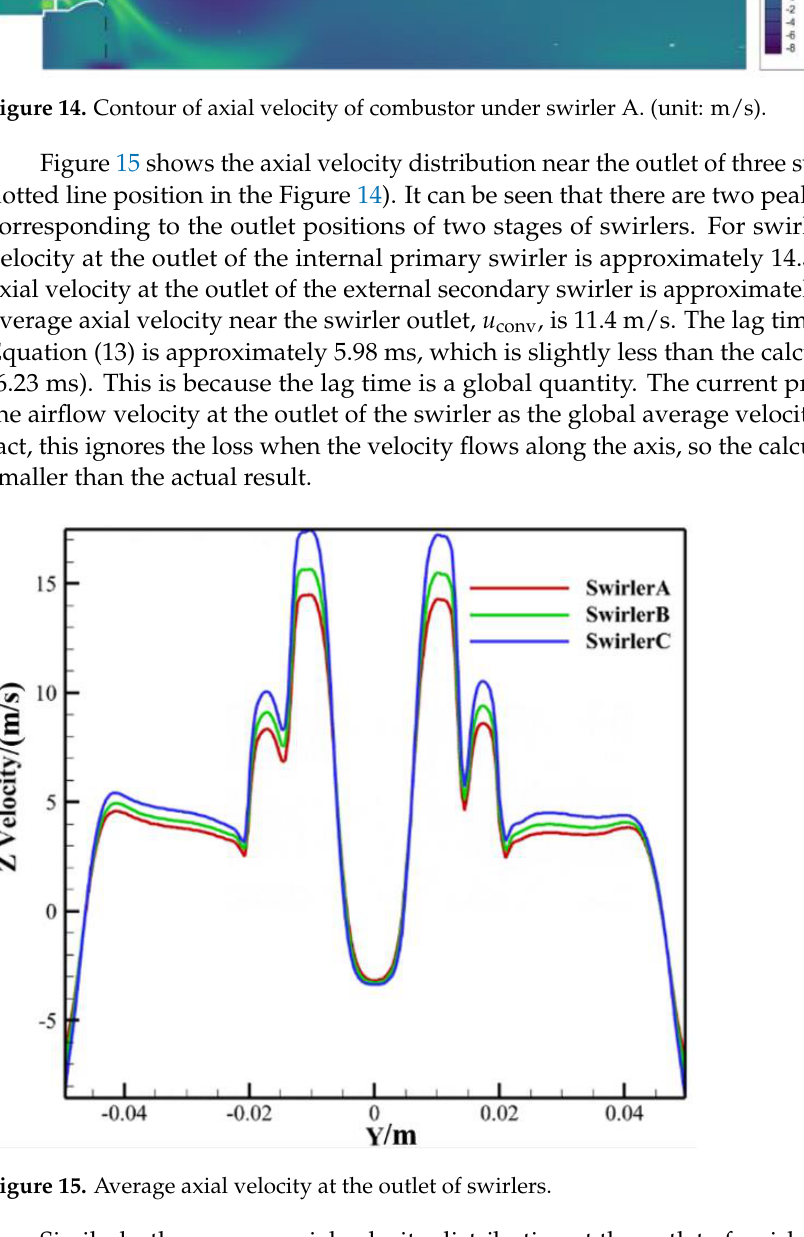
Figure 14. Contour of axial velocity of combustor under swirler A. (unit: m/s).